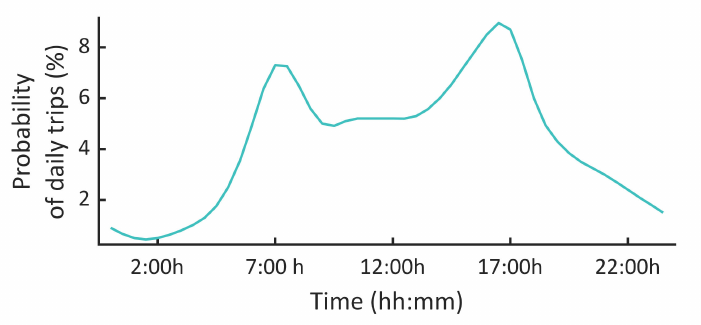
Figure 5. U.S. vehicle trip distribution on weekdays